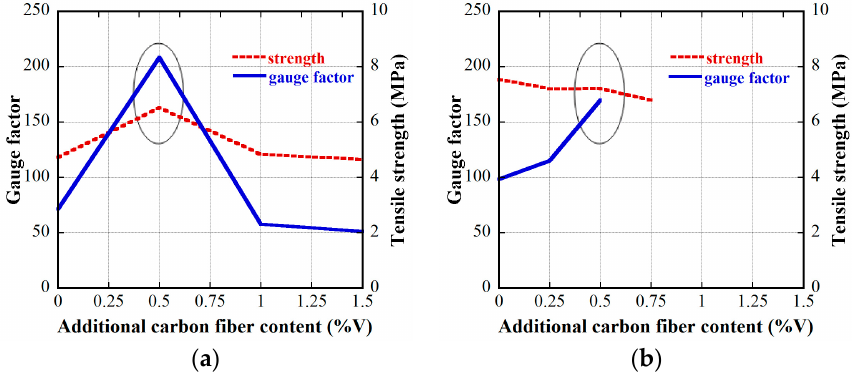
Figure 18. Comparative gauge factors of studied MSFRCs: ( a ) for MSFRC1 group; ( b ) for MSFRC2 group.